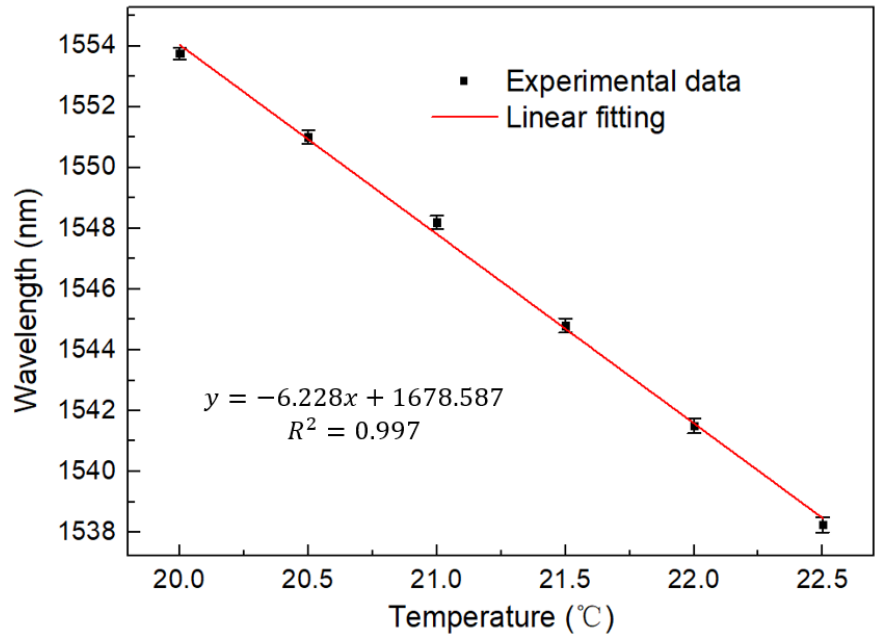
Figure 9. Linear fitting curve of wavelength and temperature of cascaded Saganc rings at 20–22.5 °C .